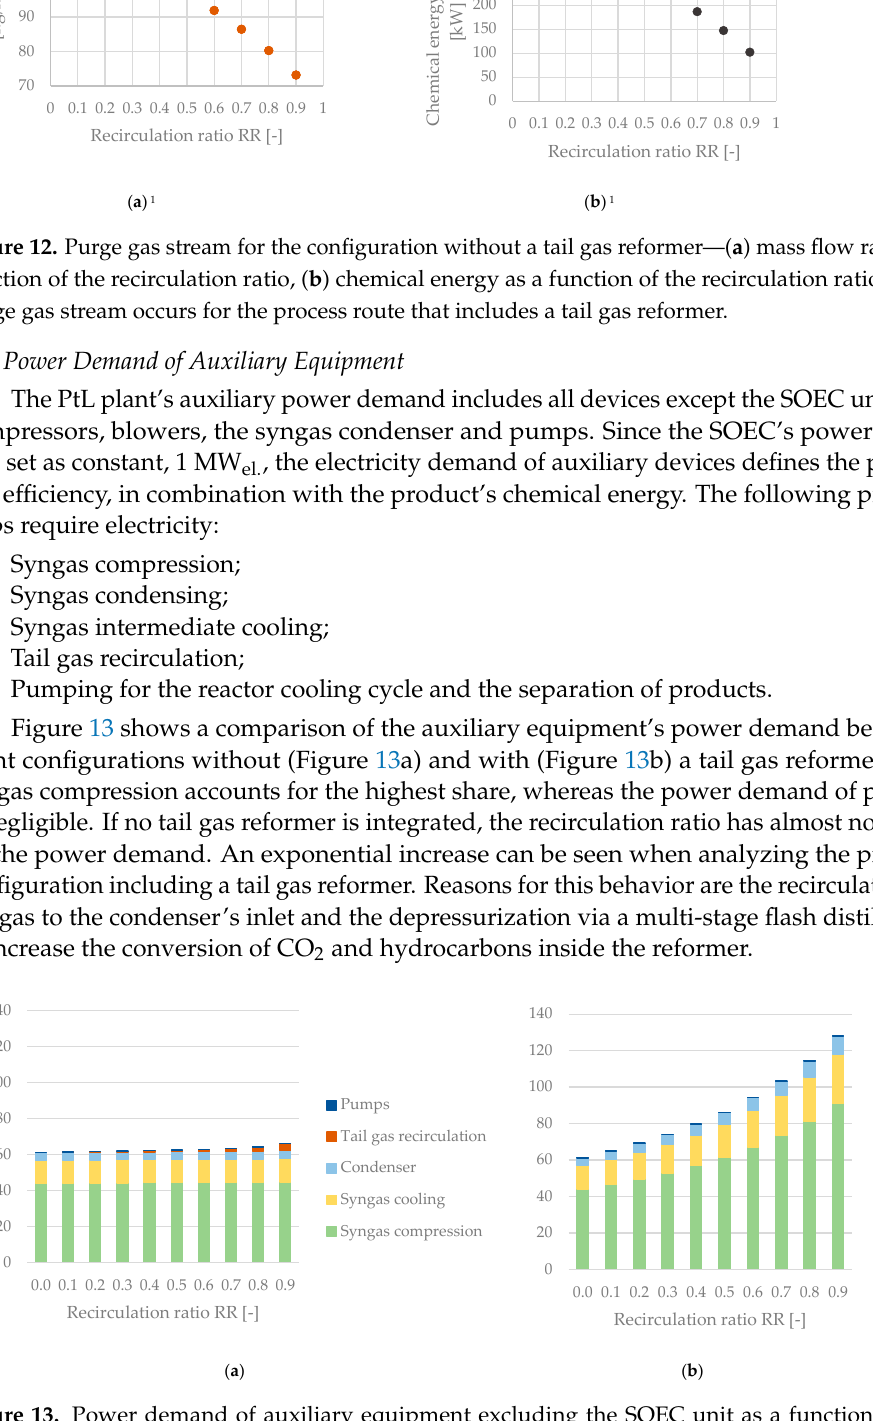
( b ) Figure 11. Tail gas reforming—( a ) tail gas composition at the reformer’s inlet, ( b ) tail gas composi- tion at the reformer’s outlet as a function of the recirculation ratio. 3.5. Purge Gas